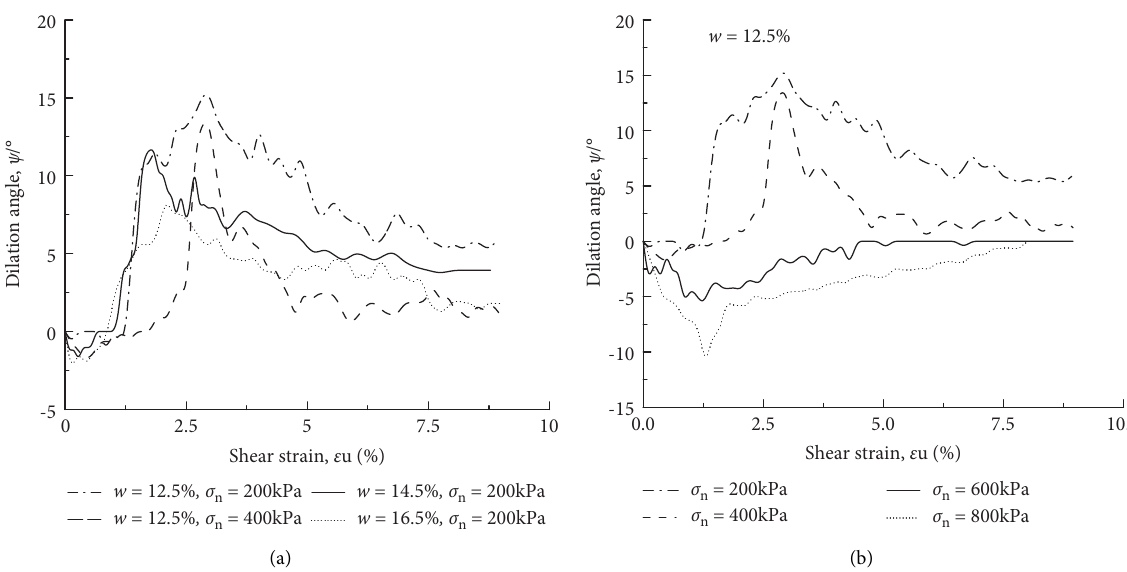
Figure 6: Variation of dilation angle with shear strain of interface. (a) Interface show shear dilation. (b) Interface with water content 12.5%.